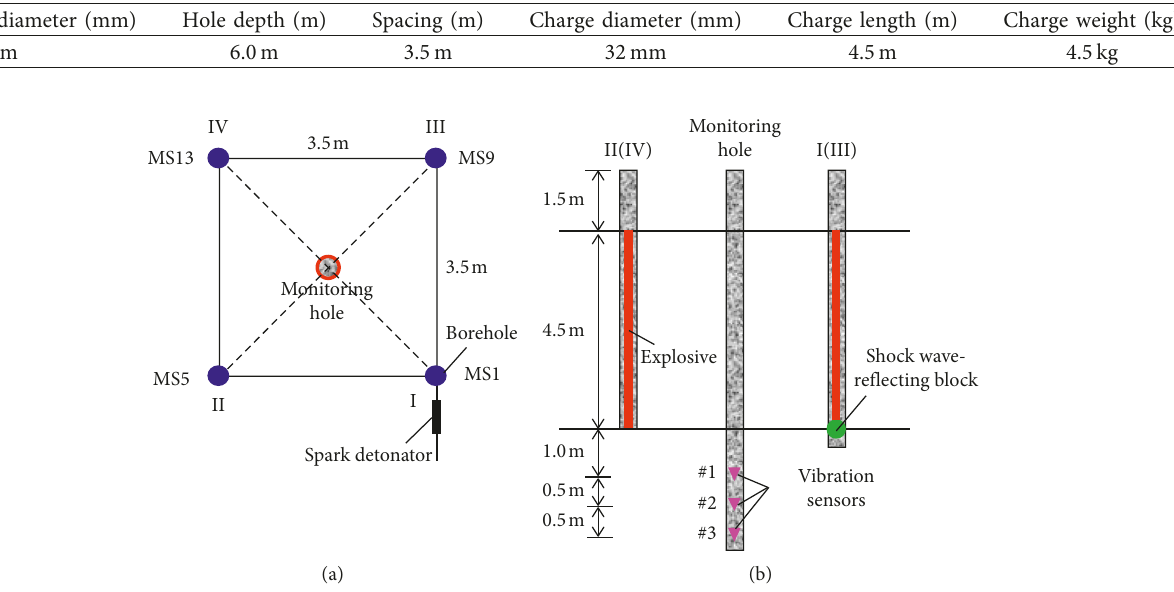
Figure 17: Arrangement of blastholes and vibration sensors in the single-hole blasting experiment. (a) Plan view of blastholes. (b) Cutaway view of